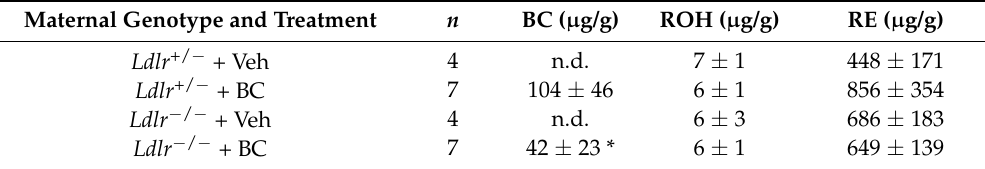
Table 2. β -carotene, retinol and retinyl ester concentrations in the livers of Ldlr +/ − and Ldlr − / − pregnant mice with or without β -carotene